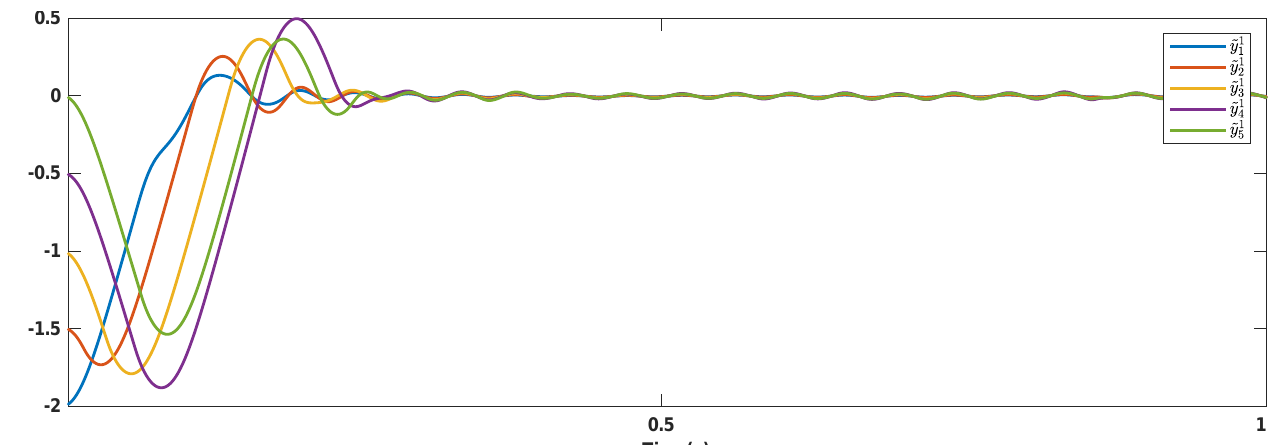
Figure 6. Example 1: Output trajectories.